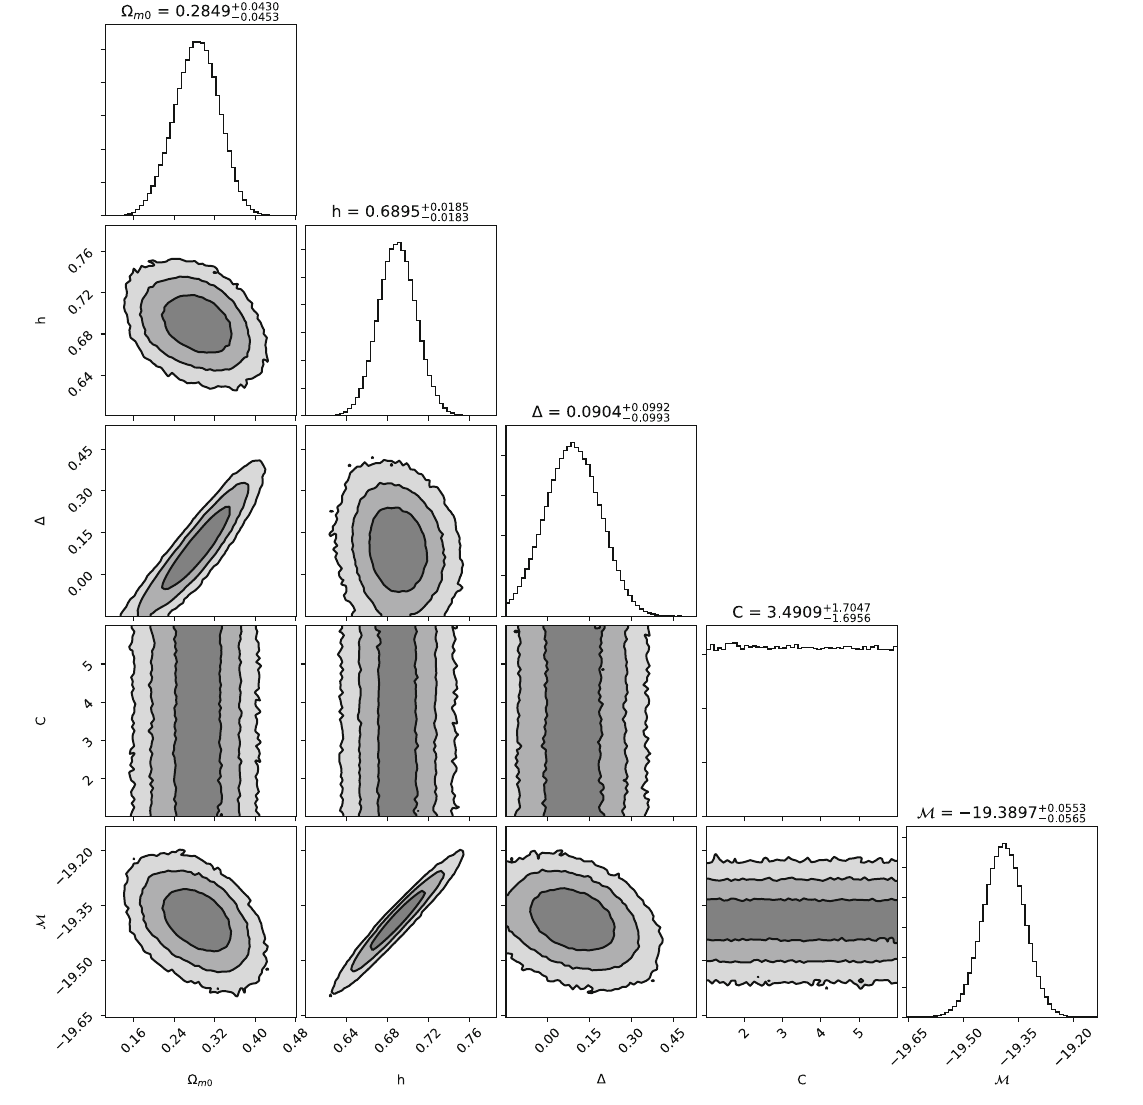
Fig. 2 The 1 σ , 2 σ and 3 σ likelihood contours for Barrow holographic dark energy, in the case where both (cid:2) and C are free parameters, using SNIa and H ( z ) data. Additionally, we present the involved 1- dimensional (1D) marginalized posterior distributions and the parame-